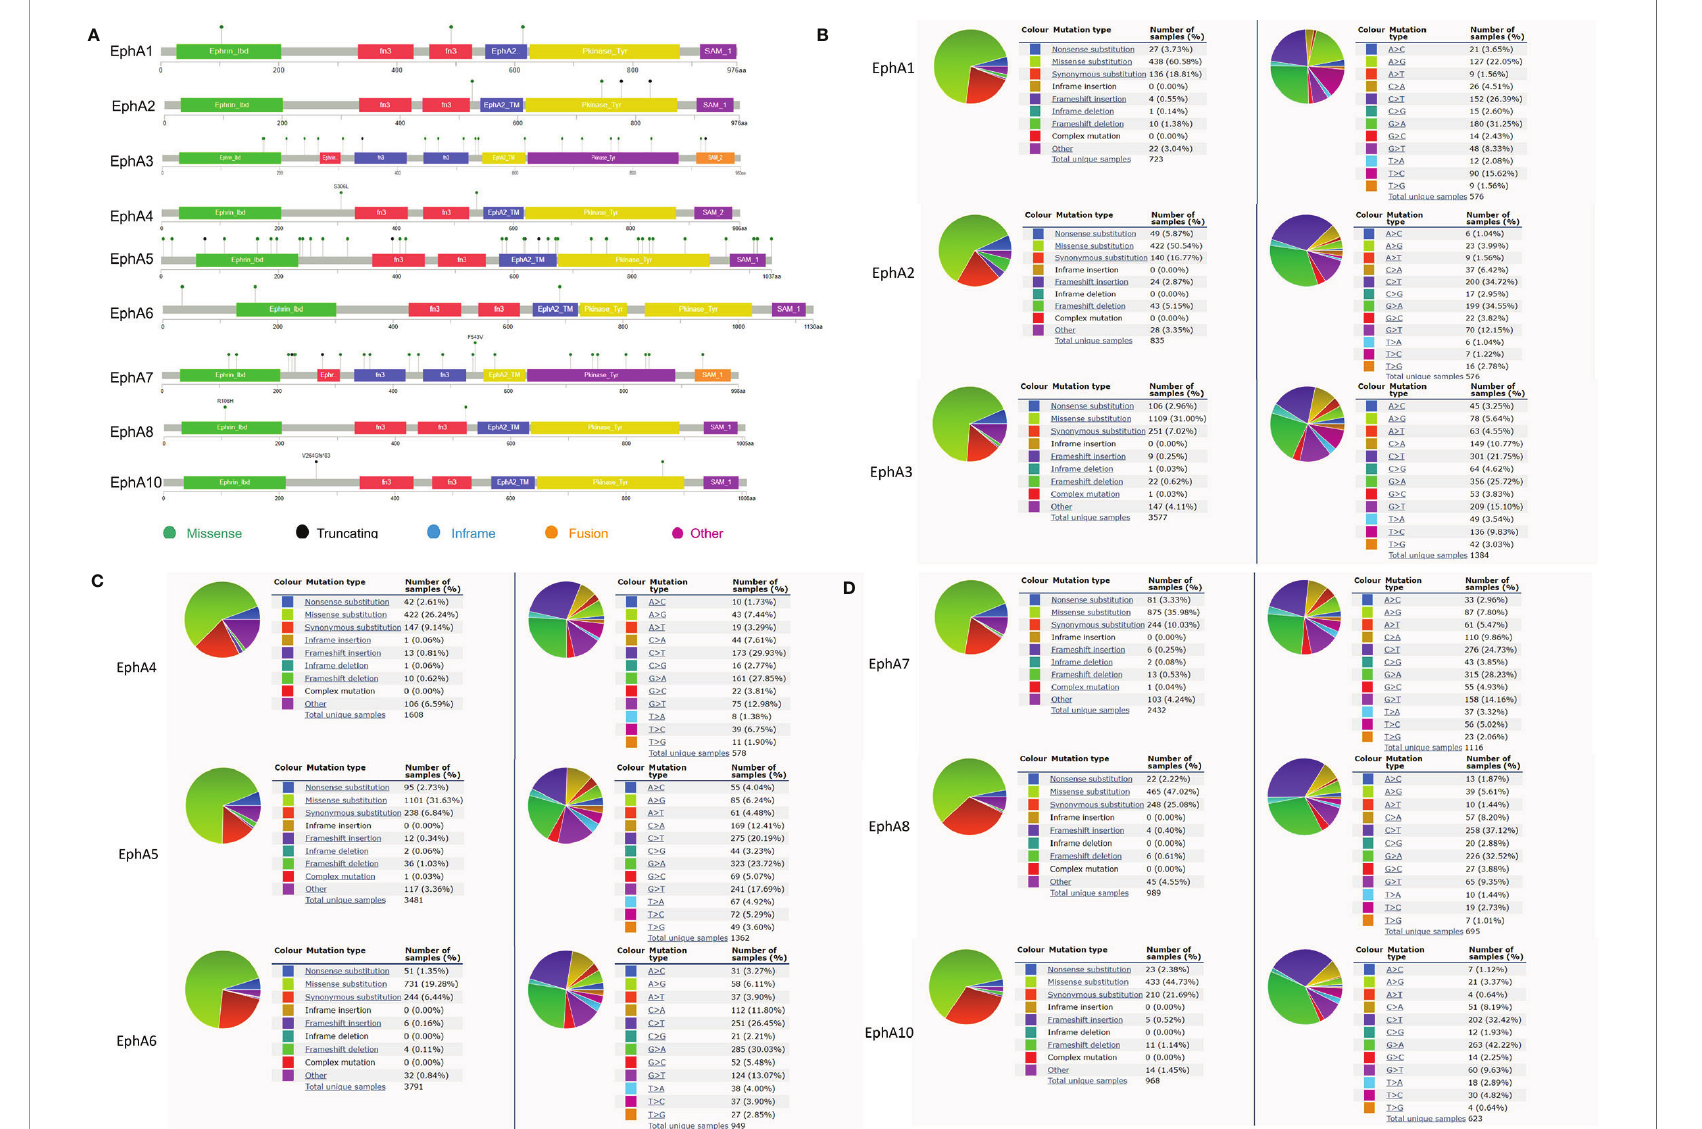
FIGURE 6 | The mutation frequency and mutation types of EphA family genes in breast cancer patients. (A) The schematic diagrams produced from the cBioportal database showed the mutation frequency of EphA family through. (B) The pie graph produced from the Catalogue of Somatic Mutations in Cancer database showed the percentages of mutation types of EphA